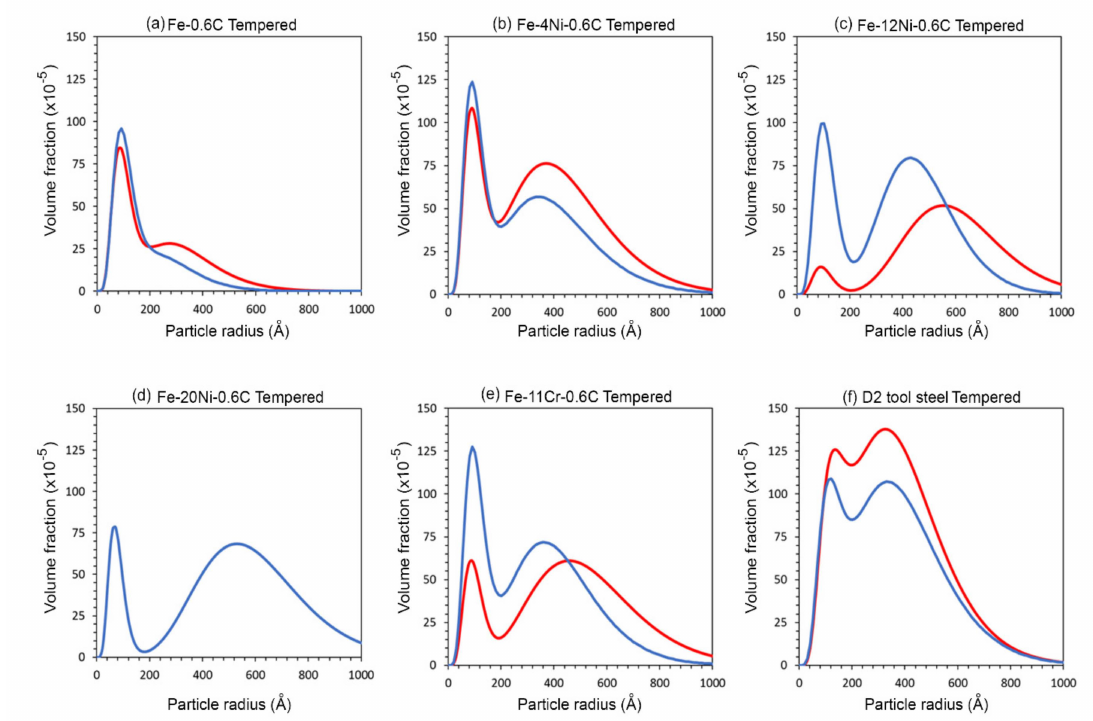
Figure 12. Particle size distribution resulting from tempering. Measured using quantitative fitting of the SANS magnetic signal. The red line indicates the Schulz distribution of non-magnetic particles in conventionally treated alloys, and the blue line indicates the Schulz distribution of non-magnetic particles in cryogenically treated